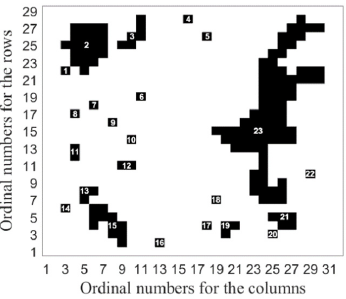
Figure 20. The map with numbered obstacles.